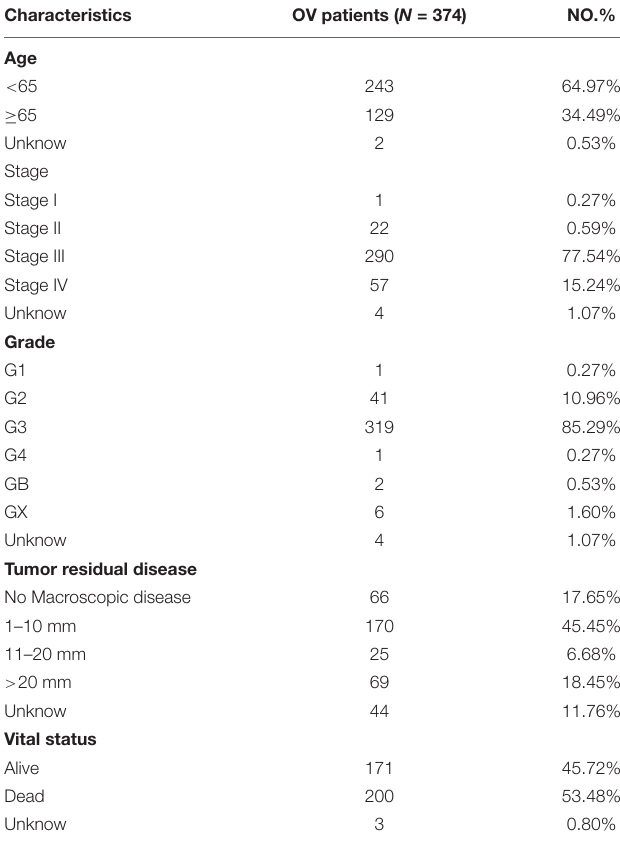
TABLE 1 | The clinical information of 374 ovarian patients in GDC dataset. Characteristics OV patients ( N =